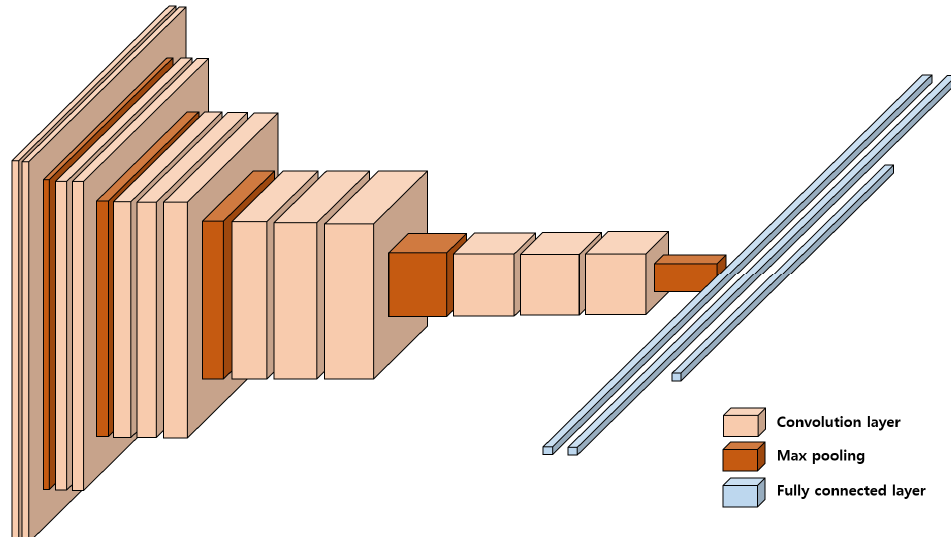
Figure 5. VGG 16 model does not include many pooling layers, so there are 13 convolution layers and three fully connected layers, totaling 16. VGG19 has three more convolution layers than